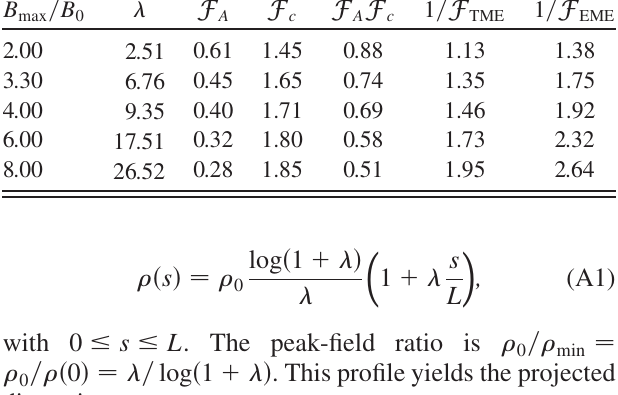
TABLE II. Potential performance of symmetric linearly in- creasing bending-radius profile in Eq. (A5) at several peak-field values. All quantities are normalized by equivalent uniform dipoles of equal length and bending angle, indicated by the caret on F